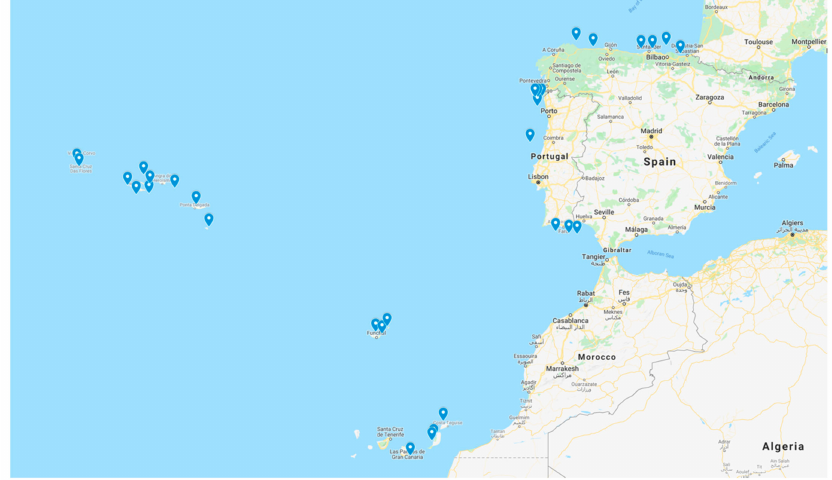
Figure 6. Locations of the study. Source: Own elaboration.